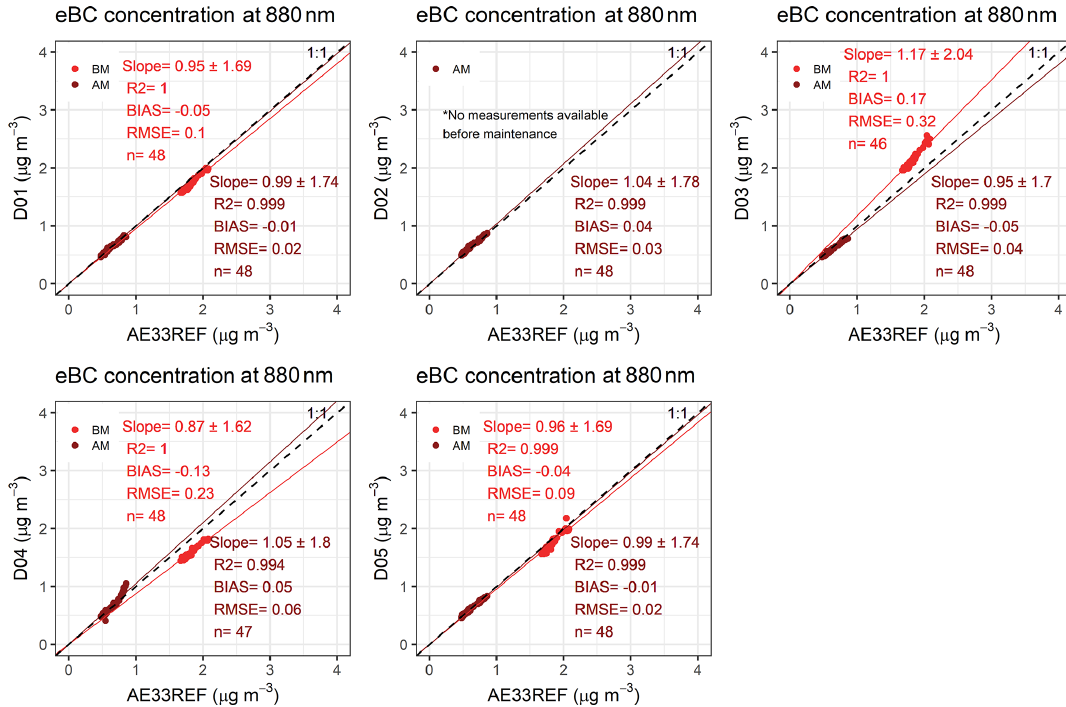
Figure 11. Regression for the comparison of the instruments in group D and the reference Aethalometer before and after maintenance during ambient air measurements. The intercept was forced through zero. BM: before maintenance. AM: after